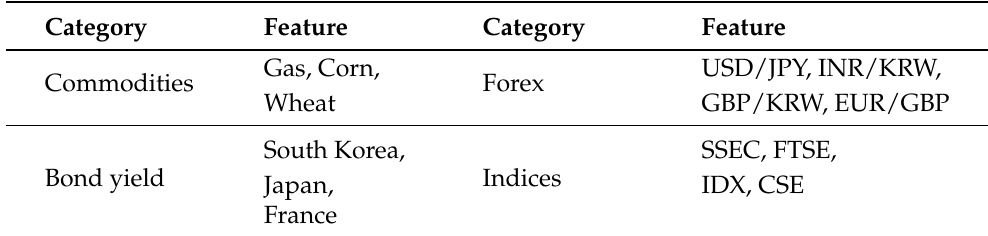
Table 3. List of features highly relevant to